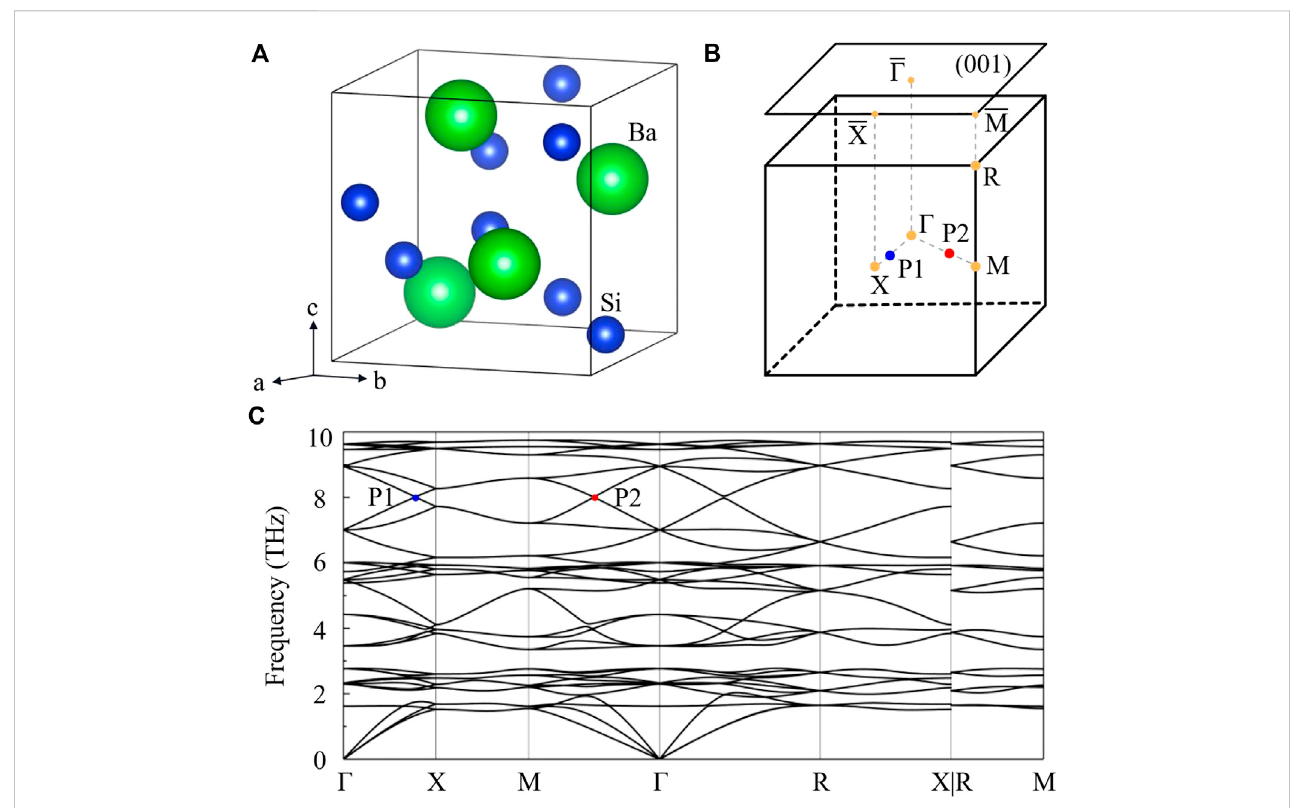
FIGURE 1 (A) The crystal structure for BaSi 2 . (B) 3D bulk and 2D surface BZs. (C) Phonon dispersion for BaSi 2. P1 and P2 are two obvious crossing